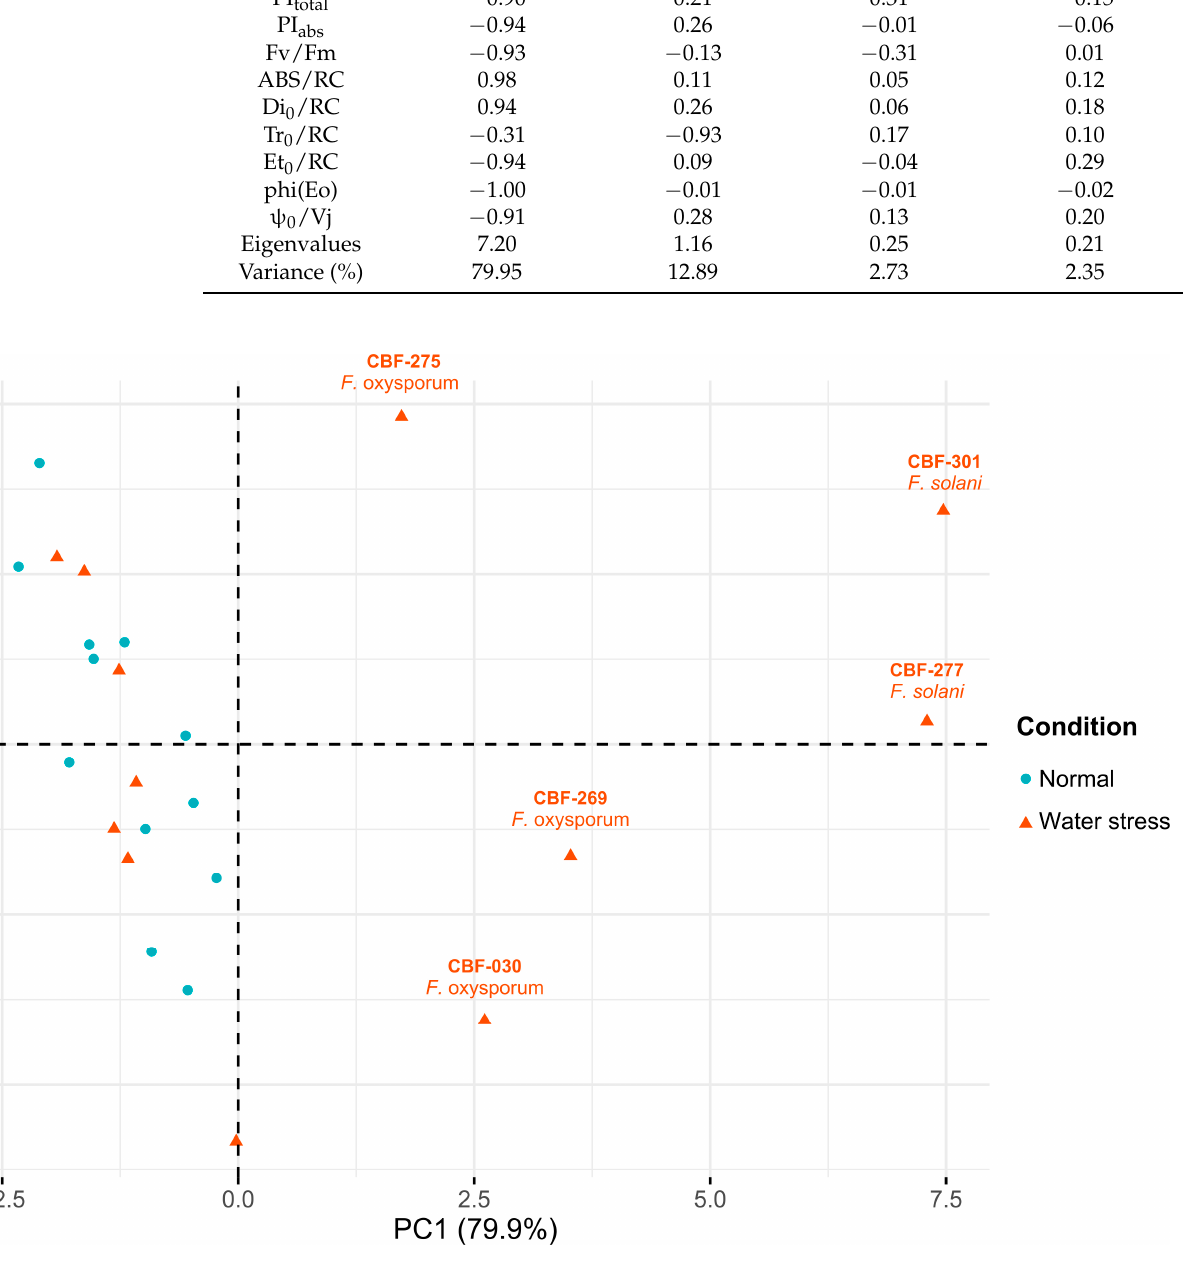
Figure 5. Principal component analysis (PCA) of Fusarium isolates based in photosynthetic parameters. PCA analysis was generated with the quantitative data of measurements PI total , PI abs , phi(Eo), Fv/Fm, ABS/RC, Dio/RC, TRo/RC, Eto/CSo, and ψ 0/Vj. The first and second PC together account for 92.8% of discriminant power.